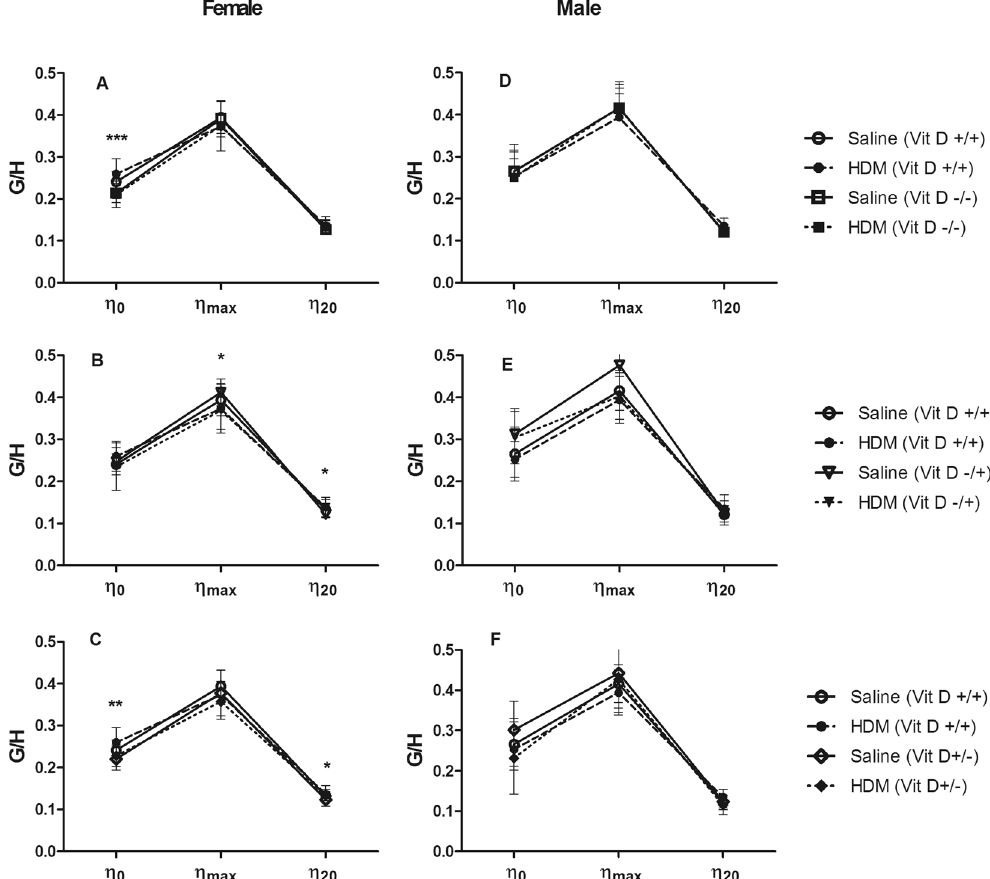
Figure 4. Hysteresivity at 0 cmH 2 O Prs ( η 0 ), 20 cmH2O Prs ( η 20 ) and the maximum ( η max ) for female ( A – C ) and male ( D – F ) saline and house dust mite (HDM) exposed mice that were vitamin D replete (Vit D + / + ), whole-life vitamin D deficient (Vit D − / − ; A , D ), in utero vitamin D deficient (Vit D − / + ; B , E ) or post-natal vitamin D deficient (Vit D + / − ; C , F ). Data are presented as mean (SD) n = 9–13 for each group. * p < 0.05; ** p < 0.01; *** p <